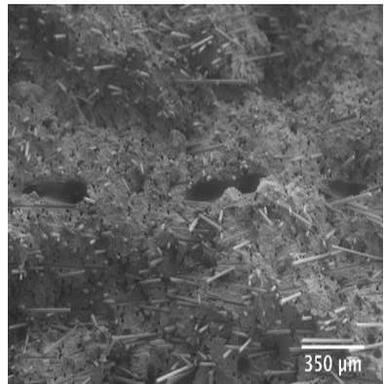
SEM image of the bond between two layers.